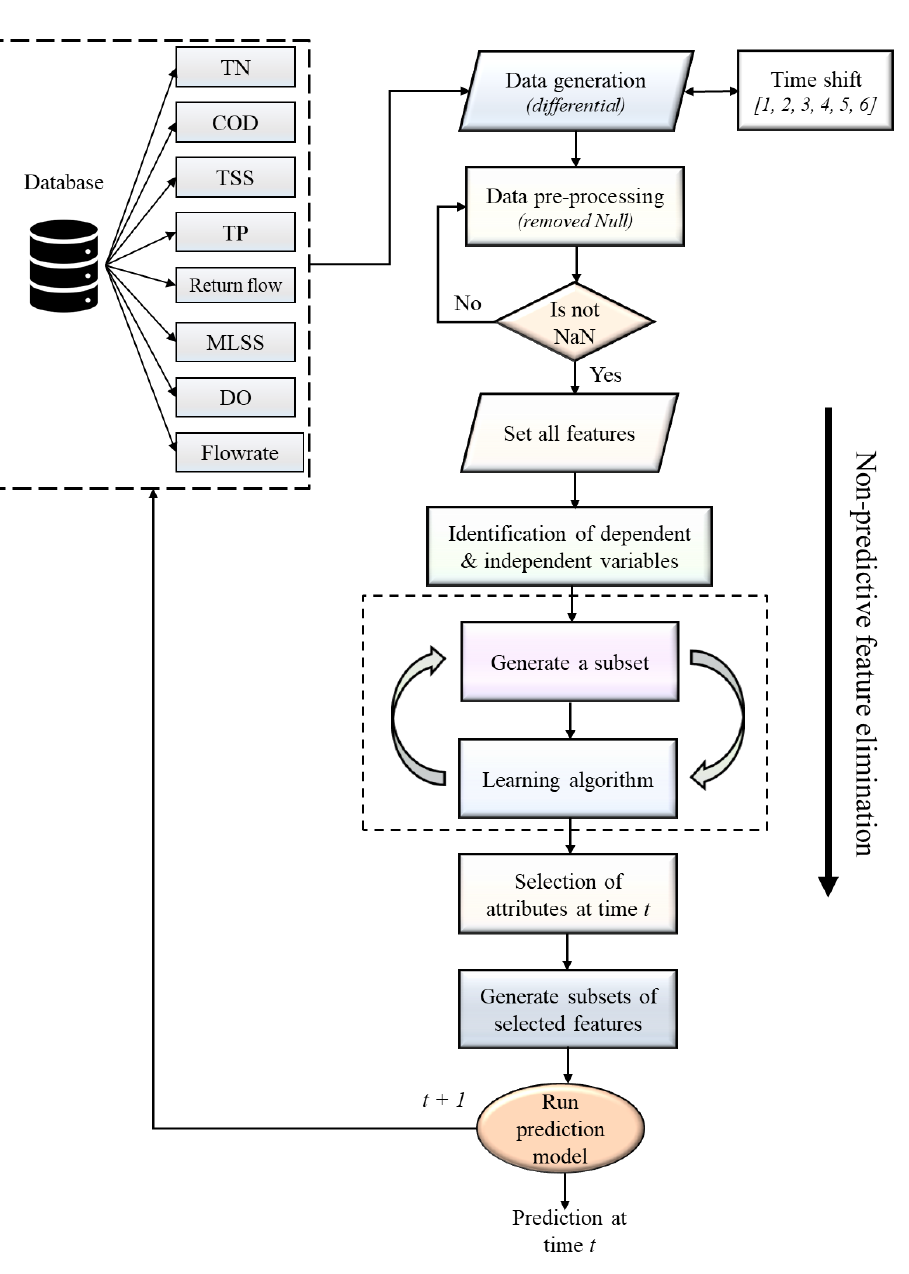
Figure 3. Architecture representation of the sensor and wastewater process feature